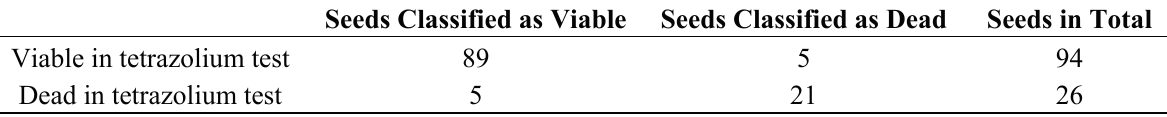
Figure 5. Plot of RegionMSI mean value of the seeds that are physically dead (positive values predicted as dead seeds and negative values predicted as viable seeds) for seed with no enzyme activity in the tetrazolium test (dead seeds). Three seed classes divided according to the colour of the seed coat (grey, black and yellow). Table 2. Data from calibration set (seed set 1). The number of viable and dead seeds observed in the tetrazolium test and the number of seeds classified as dead and viable in the calibration model, based on an nCDA transformation employed in the Region MSI